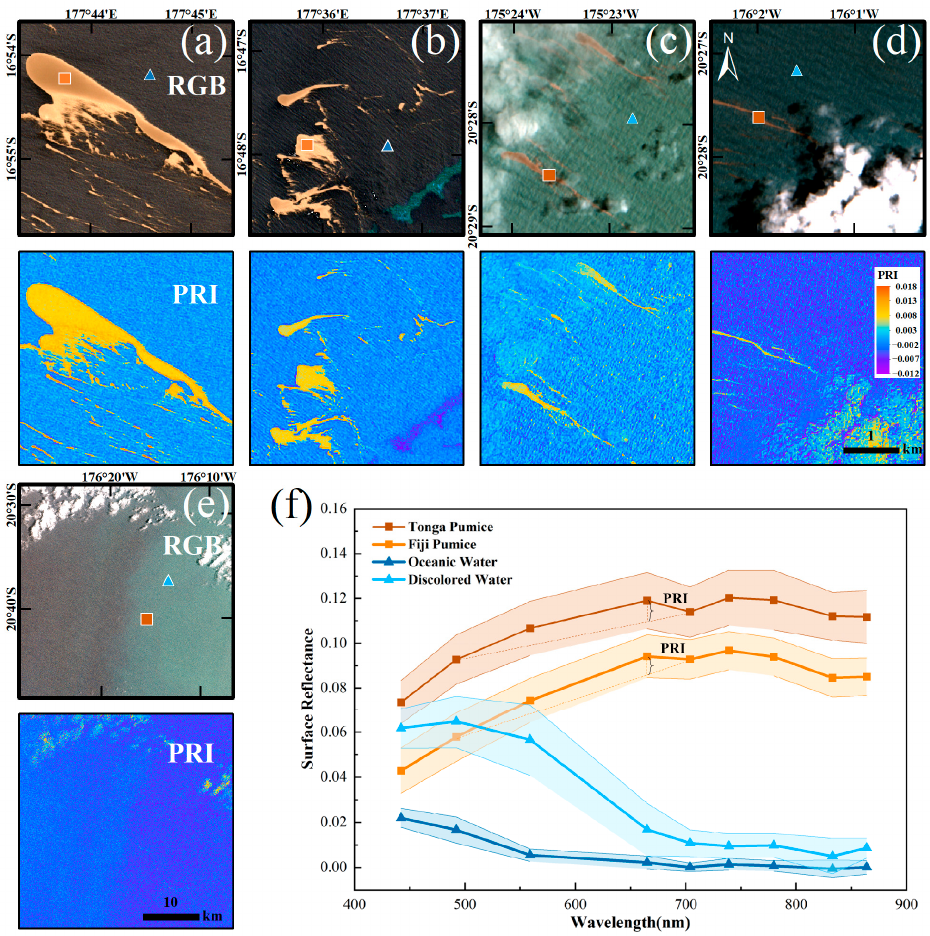
Figure 2. RGB true color and the corresponding PRI images in sub regions ( a – e ). Sub-regions in panels a and b were from near the Fiji Yasawa islands with background of regular oceanic water, while the sub-regions in panels ( c – e ) were from near Hunga Tonga island with a background of mostly discolored water. Clear contrasts can be observed from the pumice with the background water in the PRI image. ( f ) Average reflectance spectra of pumice and water in selected locations, partly marked in panels ( a – e ). Standard deviations of the spectra are shown in shaded areas.